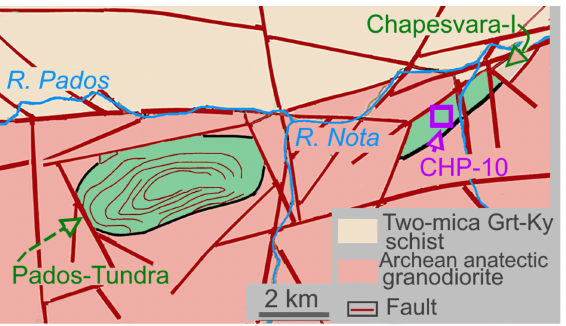
Figure 4. Schematic geological map shows the regional geology, modified slightly from [16]. The location of the sample CHP-10 is displayed by the purple